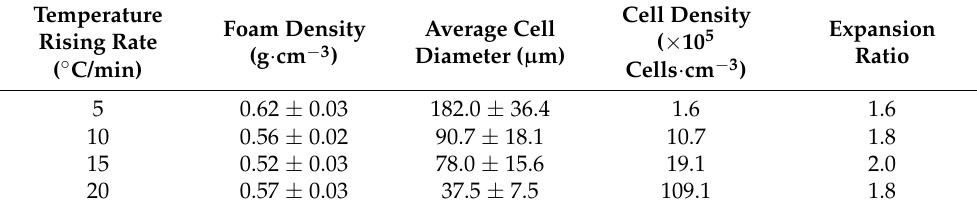
Table 7. Parameters of foamed samples with different temperature-rising